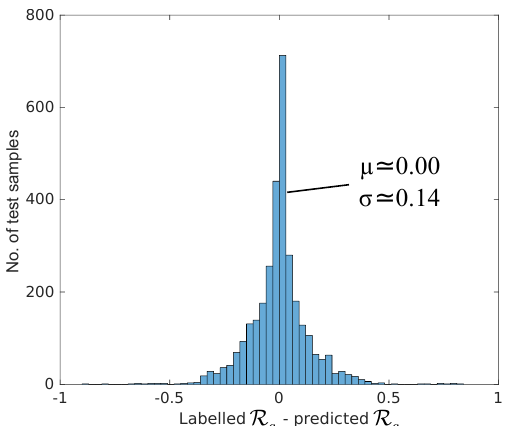
Figure 10. Distribution of the classification error between the rim- ing index calculated from the true labels and the riming index pre- dicted by the MLR model. The y axis shows the number of test samples contained within each bin.